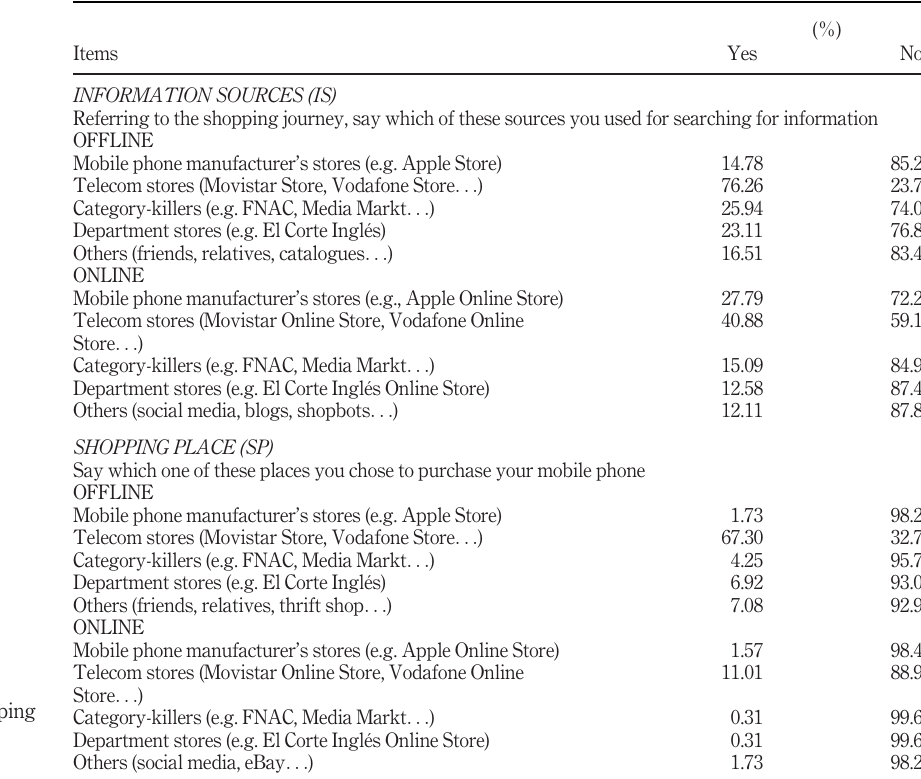
measurement (Question II)